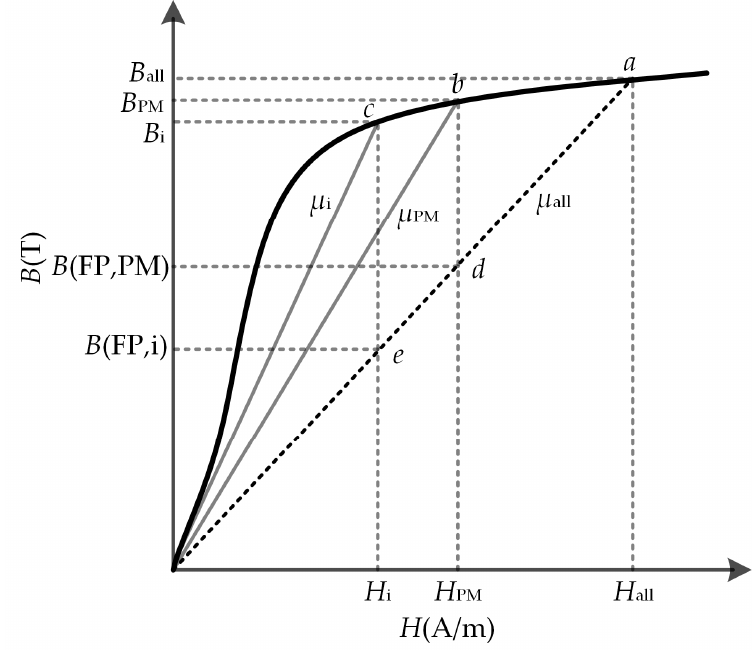
Figure 1. Principle of frozen permeability.